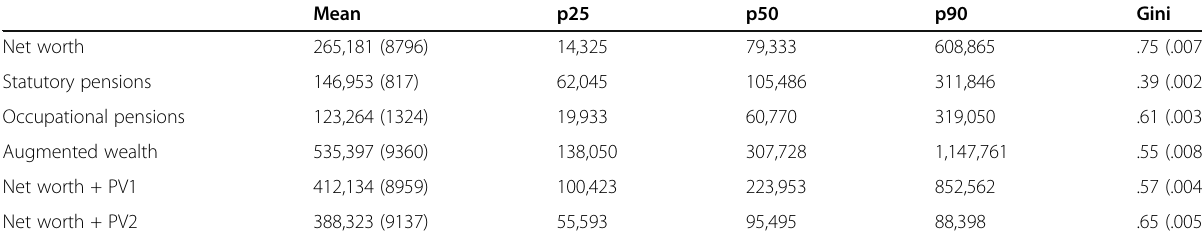
Table 4 Descriptive statistics of pension wealth and augmented wealth in 2015 (household level, values per